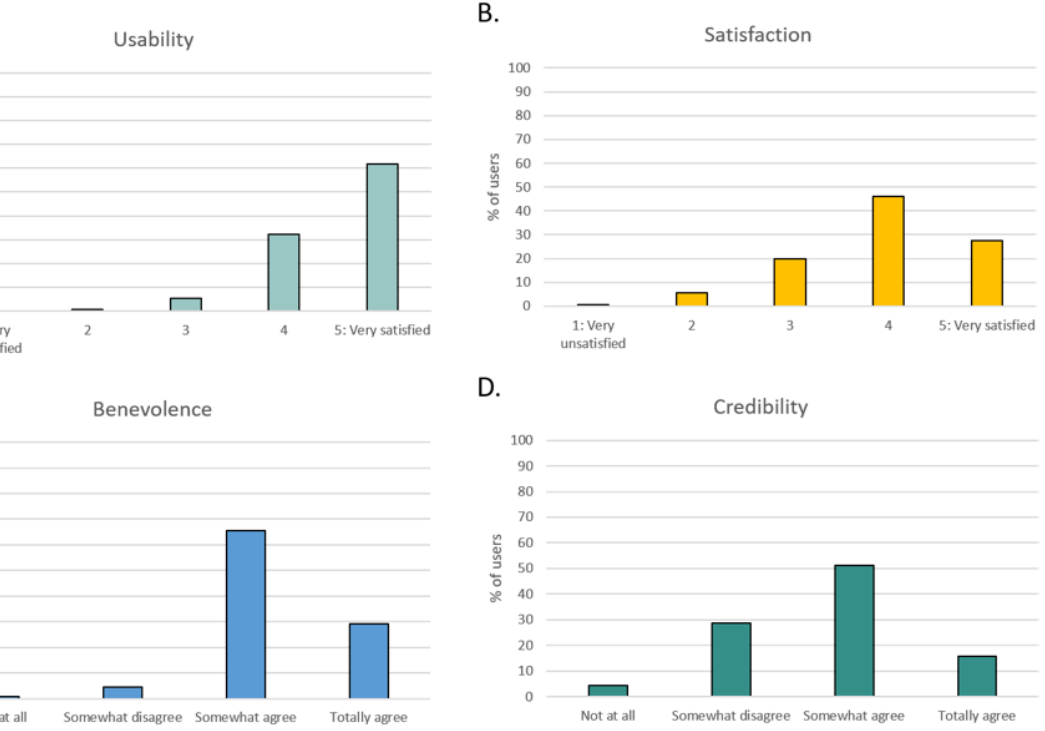
Figure 4. Distribution of usability, satisfaction, benevolence, and credibility perception of the virtual companion for sleep disorders (Louise). (A) Percentage of users’ rating for usability dimension (AES subscore), (B) percentage of users’ rating for satisfaction dimension (AES subscore), (C) percentage of users’rating for benevolence dimension (ETQ subscore), and (D) percentage of users’rating for credibility dimension (ETQ